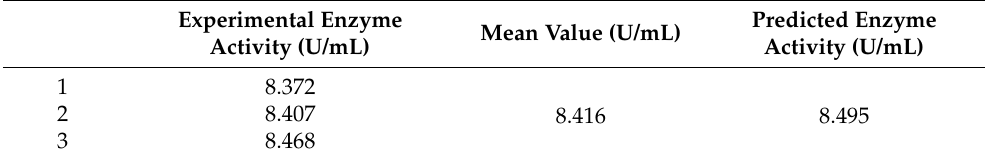
Figure 2. Response surface ( a – c ) and contour plots ( d – f ) of the effects of κ -selenocarrageenan concentration ( A ), Ca 2+ concentration ( B ) and temperature ( C ) on κ -selenocarrageenase activity. To sum up, the three factors corresponding to the highest enzymatic activity of the response surface map were 1.6% κ -selenocarrageenan (theoretical value 1.59%), 3.7 mmol/L Ca 2+ (theoretical value 3.69 mmol/L), and the temperature 33 ◦ C (theoretical value 32.52 ◦ C), respectively. The maximum predictive activity was 8.495 U/mL, increased by about 1.4 times compared with the original enzyme activity (6.079 U/mL). In comparison with 2.14 U/mL of optimized κ -carrageenase production by Cellulosimicrobium cellulans [20] investigated, the optimized enzyme activity of Xi13 with 8.495 U/mL was significantly higher. Three parallel fermentation experiments were repeated, and the enzyme activities were 8.372, 8.407 and 8.468 U/mL, respectively. The average value was 8.416 U/mL, which is in good agreement with the predicted value (8.495 U/mL), indicating that the model could predict the κ -selenocarrageenase production (Table 2) very well. Table 2. Verification